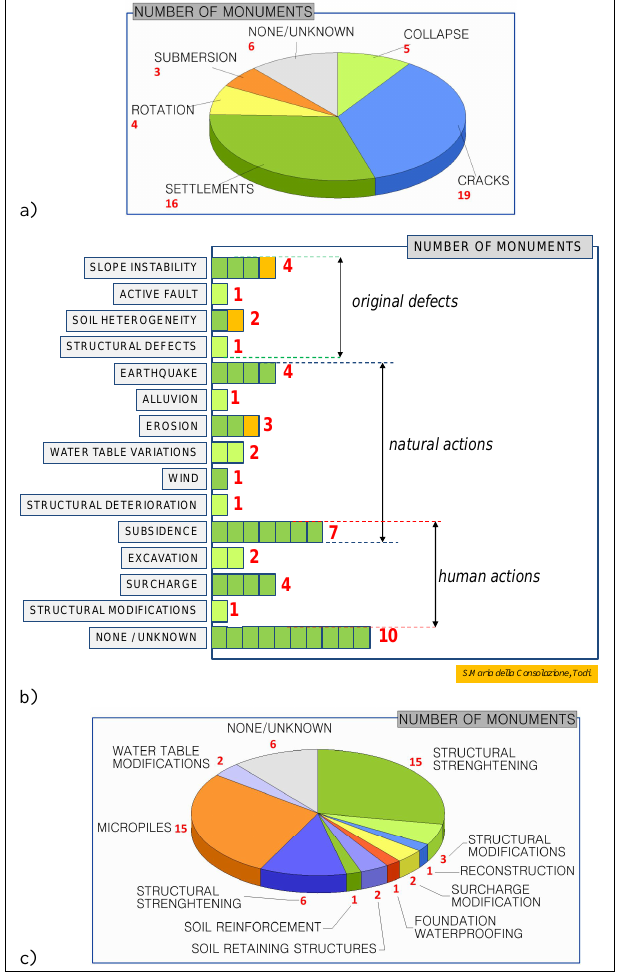
Figure 14. Analysis of some Italian monuments (modified from Cecconi et al. 1997): a) damage types; b) possible causes of damage; c) preservation measures.